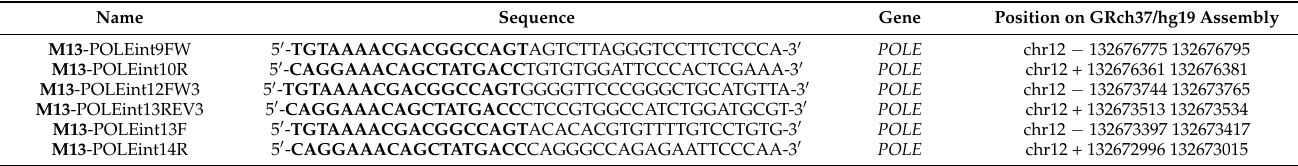
Table 2. Primers used for PCR